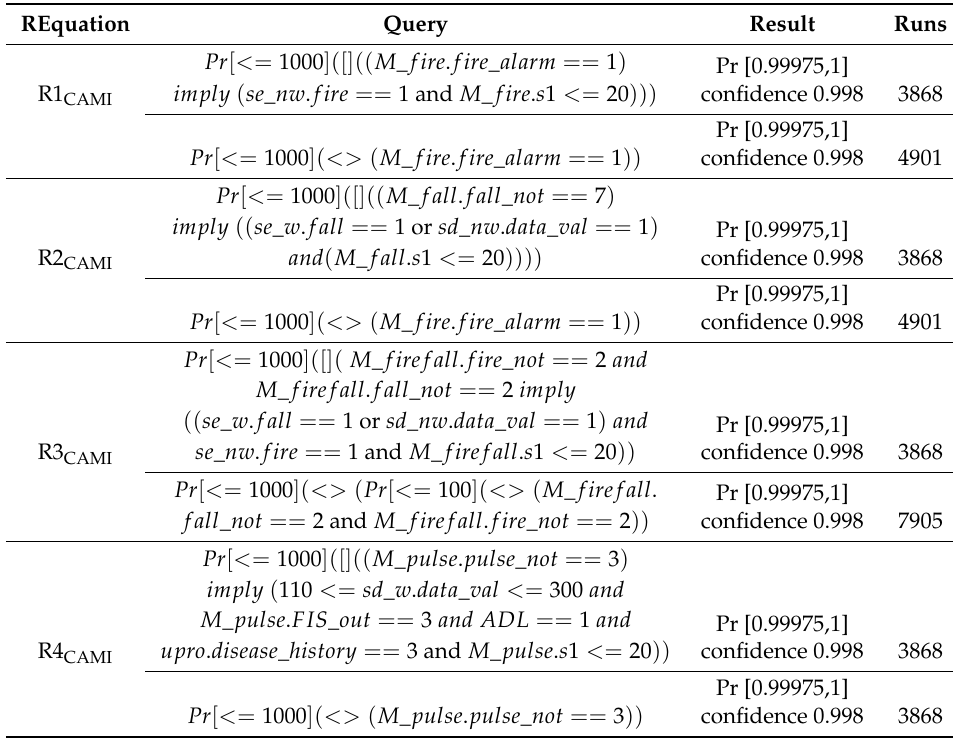
Table 3. UPPAAL SMC analysis results of